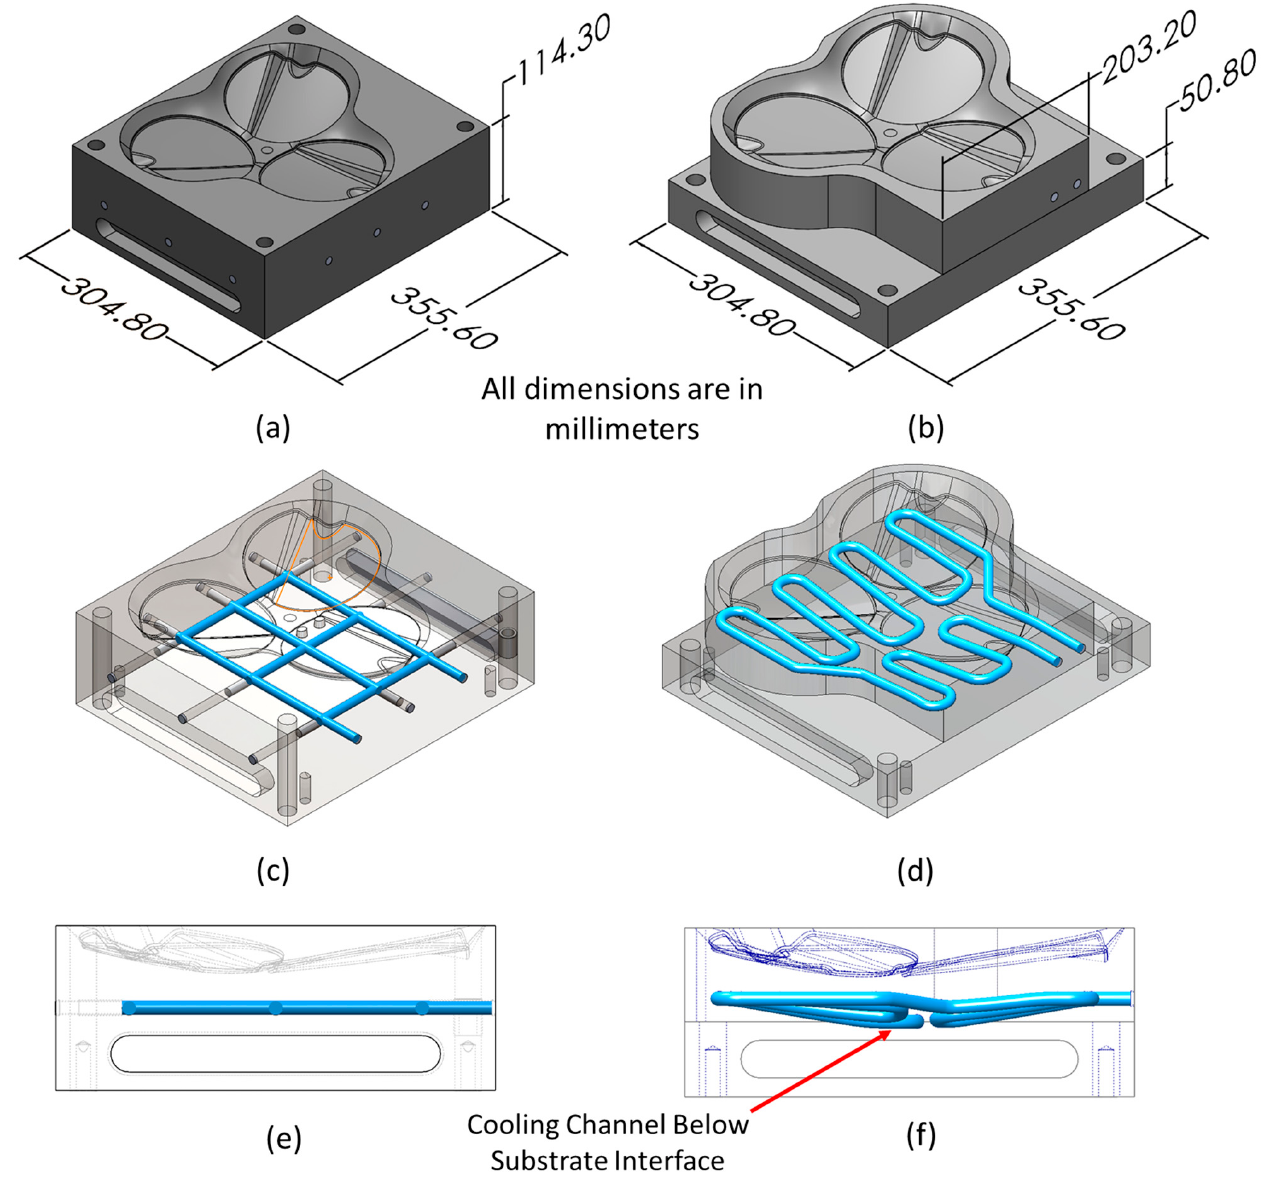
Figure 1. Mold design (upper half of mold not shown): ( a ) isometric view of traditional (machined) mold with overall dimensions; ( b ) isometric view of optimized (printed) mold with overall dimensions; ( c ) isometric view of traditional cooling channels; ( d ) isometric view of conformal cooling channels; ( e ) side view of traditional cooling channels; and ( f ) side view of conformal cooling